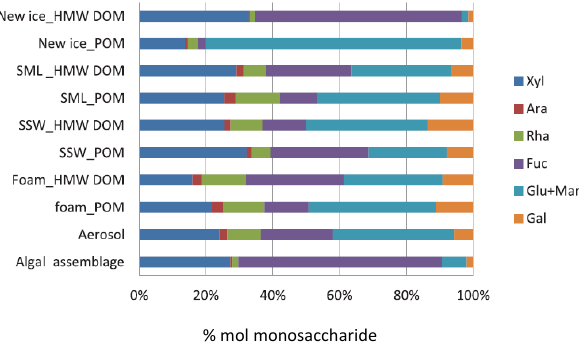
Fig. 4. Relative mole percentage of monosaccharides (% mol) in new ice, surface microlayer (SML), subsurface seawater (SSW), foam layer, aerosols and algal assemblage. Shown are xylose (Xyl), arabinose (Ara), rhamnose (Rha), fucose (Fuc), the sum of glucose (Glu) and mannose (Man), and galactose (Gal) in the high molecu- lar weight dissolved (HMW DOM) and particulate (POM) organic matter, except aerosol and algal assemblage which were not frac- tionated (See Sects. 2.3 and